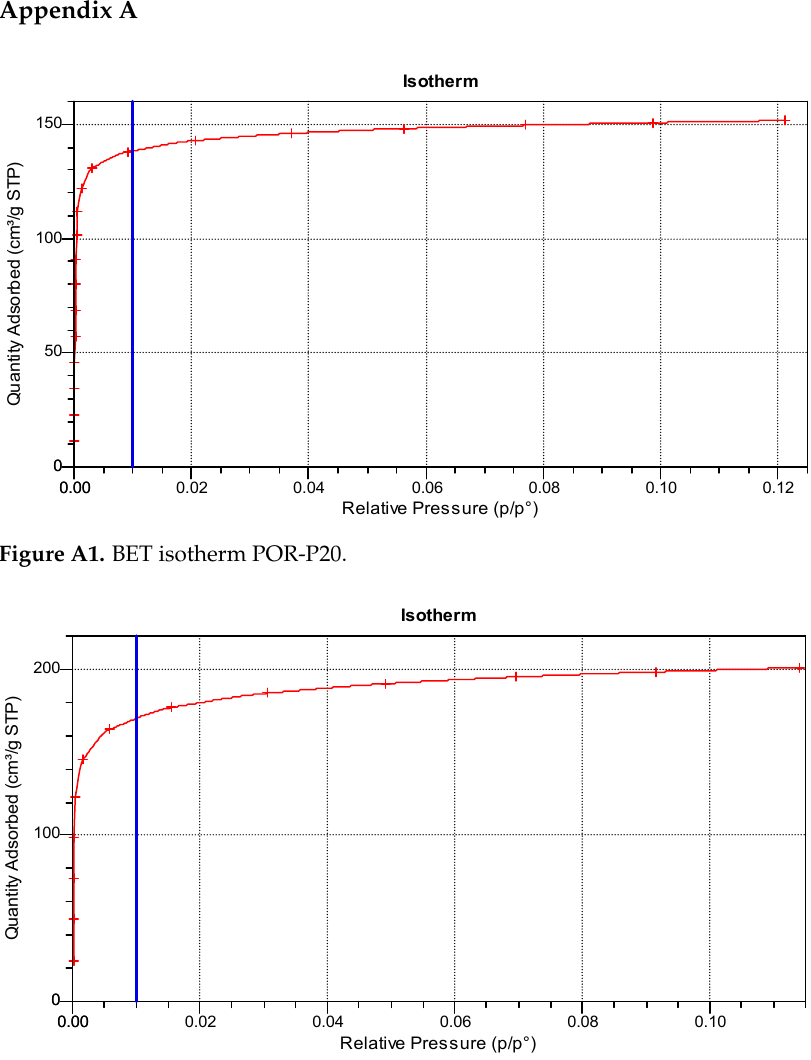
Figure A3. BET isotherm POR-C11.